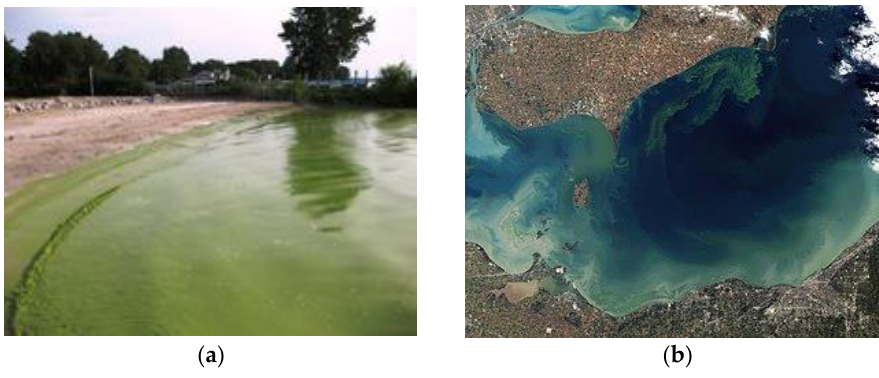
Figure 1. Cyanobacteria (blue-green algae) blooms on Lake Erie in ( a ) 2009 and ( b ) 2011. Magnitude and frequency of HABs are increasing globally [19]. Early detection and